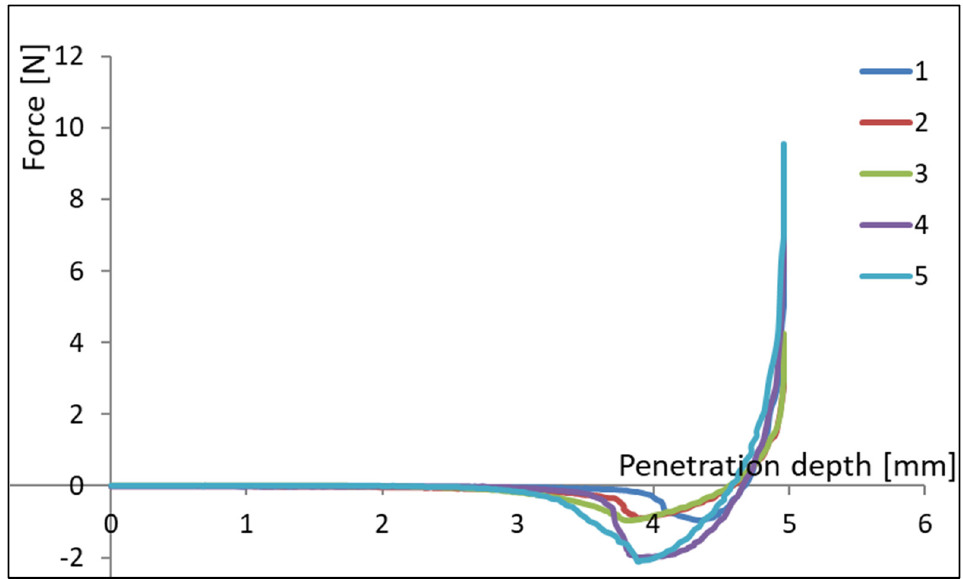
Figure 1. The PS 10 penetrometer force–penetration depth curves of butter samples.